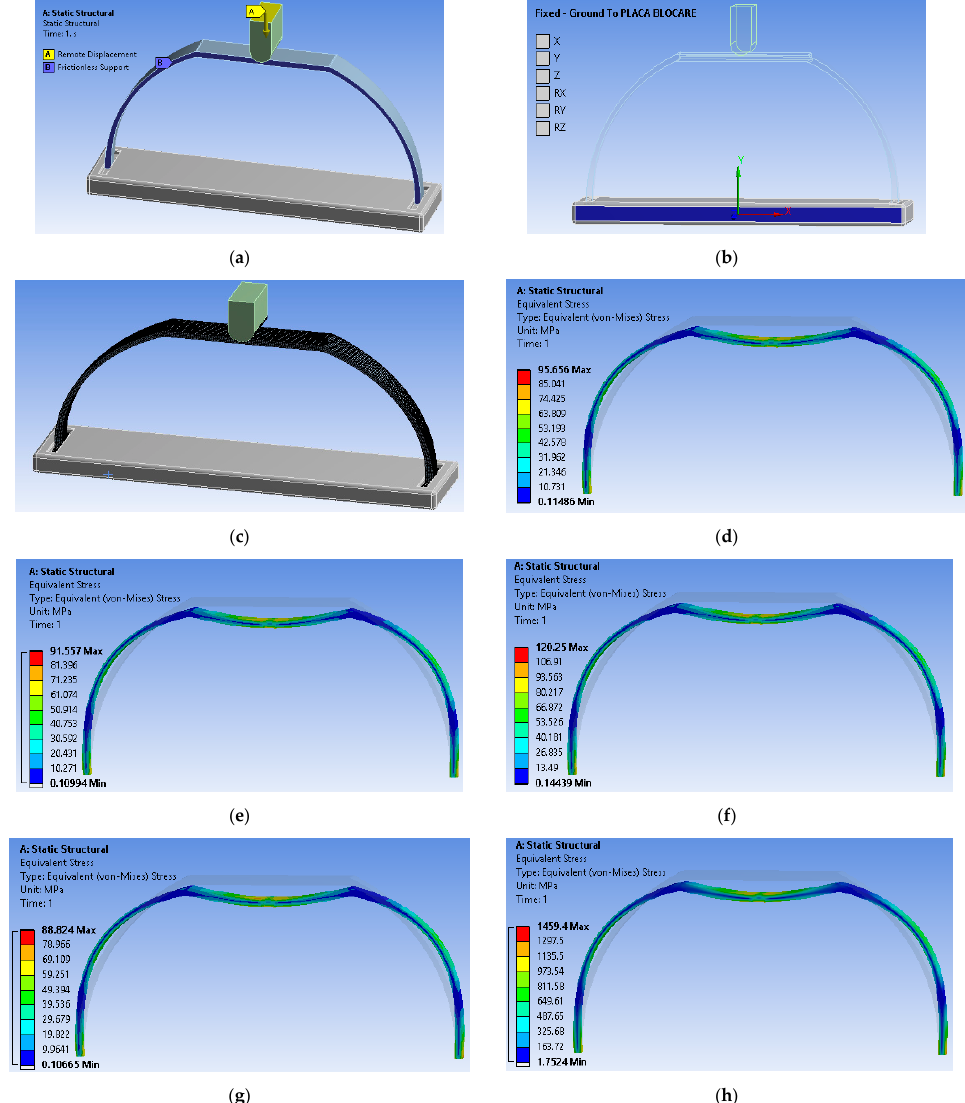
Figure 4. Finite element analysis of landing gear models: ( a , b ) set up boundary conditions; ( c ) discretization of the model; ( d ) equivalent stress distribution for landing gear made of material PLA GF; ( e ) equivalent stress distribution for landing gear made of material PP GF30; ( f ) equivalent stress distribution for landing gear made of PET CF15 material; ( g ) equivalent stress distribution for landing gear made of material PAHT CF15; ( h ) equivalent stress distribution for landing gear made of CFRP material.